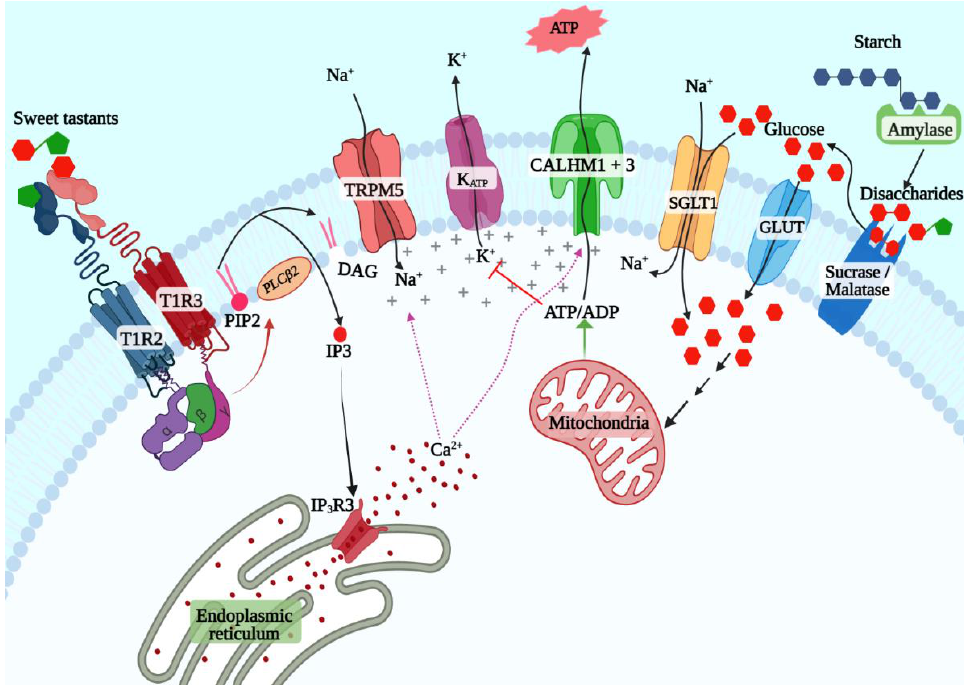
Figure 1. T1R2 + T1R3-dependent and -independent sweet taste signaling pathways. TAS1R2 + Figure